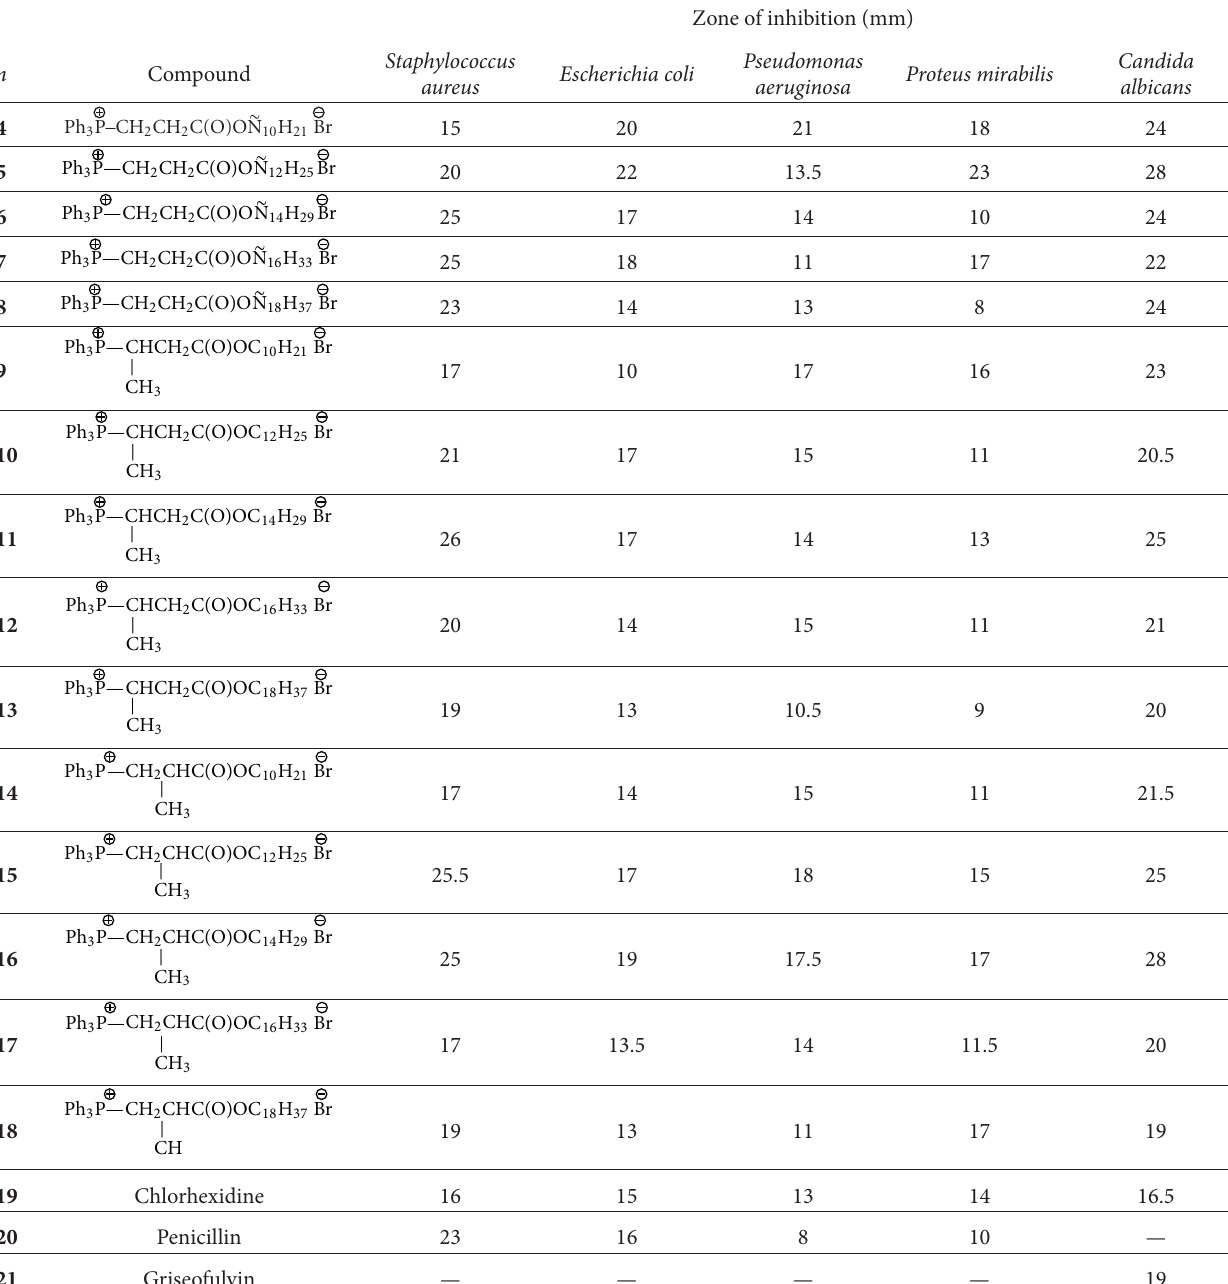
T 1: Antimicrobial activity of the newly synthesized compounds and the control drugs (50